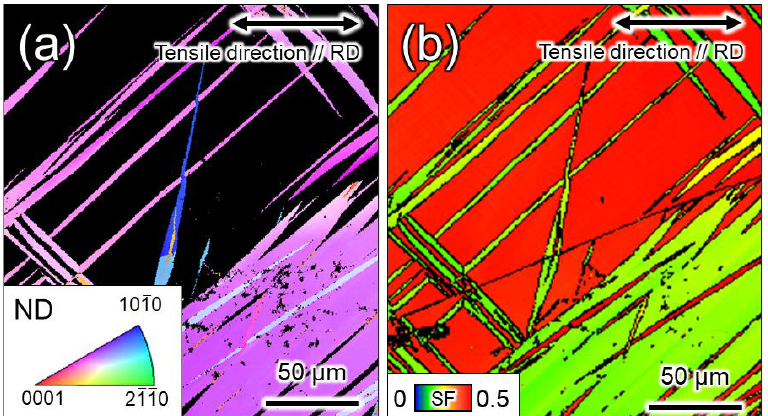
Figure 16. ( a ) Crystal orientation distribution map highlighting only the inside of the twin boundary and ( b ) SF map of prism dislocation slip for the tensile direction in Ti-210 deformed 14% at high strain rates (10 0 s −1 ).